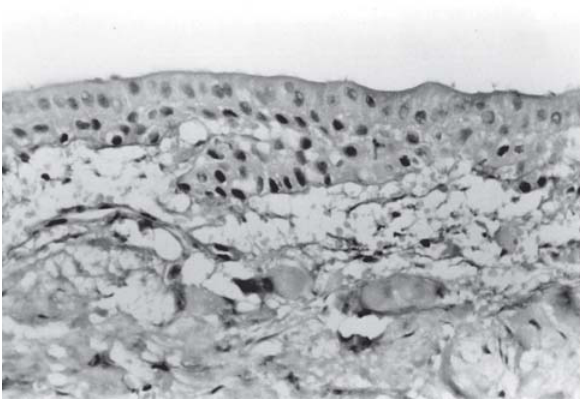
FIGURE 6- Reduced enamel epithelium: nuclei of basal cells darker due to PCNA expression.